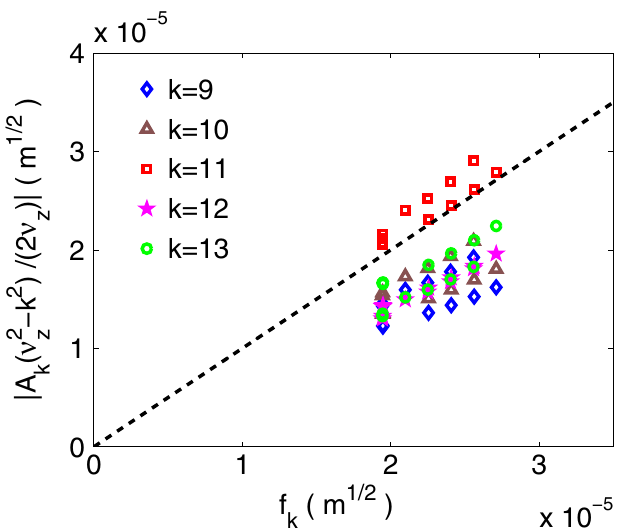
FIG. 6. (Color) Comparison of A vertical dispersion function with the Fourier harmonics f Eq. (18). The vertical dispersion function is generated by a 1 mrad dipole roll to different dipoles in the QBA-lattice